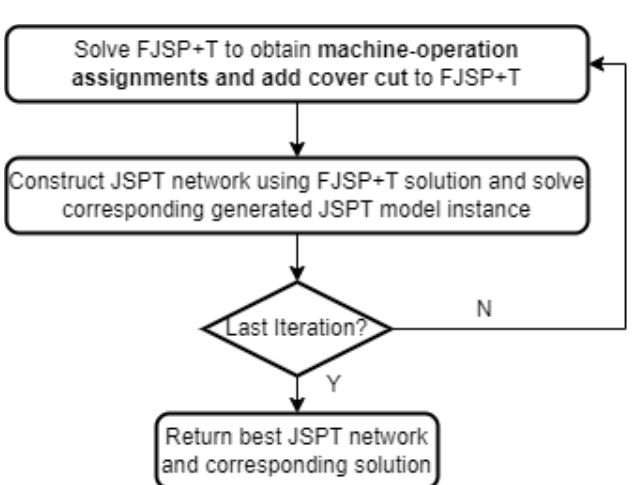
Figure 1. High level schematic of two-phase iterative